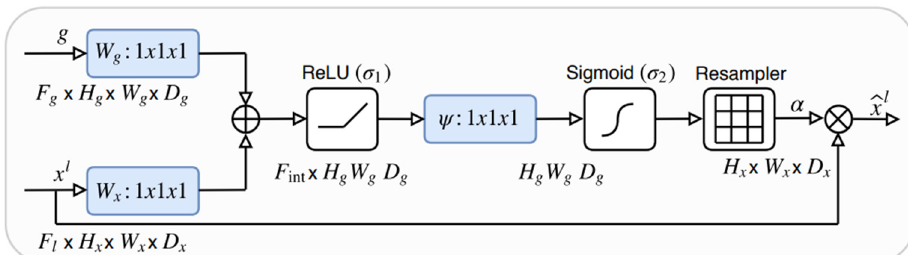
Figure 4. Architecture of attention module.